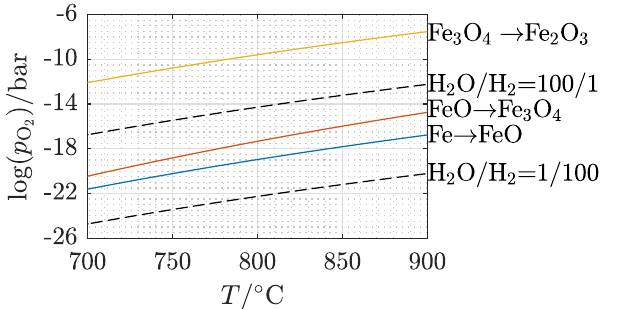
Figure 4. Equilibrium partial pressure of oxygen in H 2 O/H 2 mixtures as a function of temperature (dashed lines) compared to the dissociation pressures of the different iron oxide reactions (solid lines) (calculated on the basis of